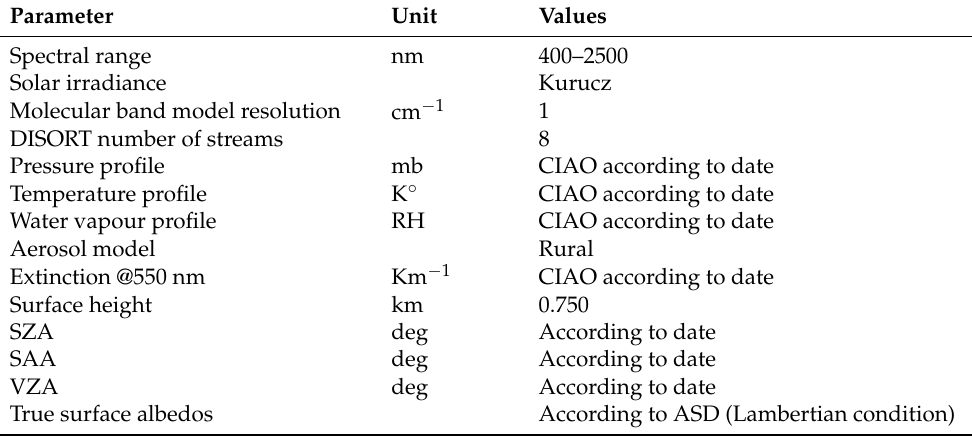
Table 3. List of the configuration parameters used for the RT L TOA